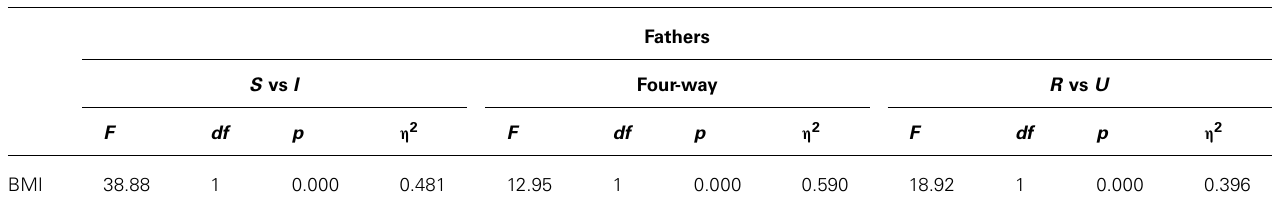
Mothers Fathers